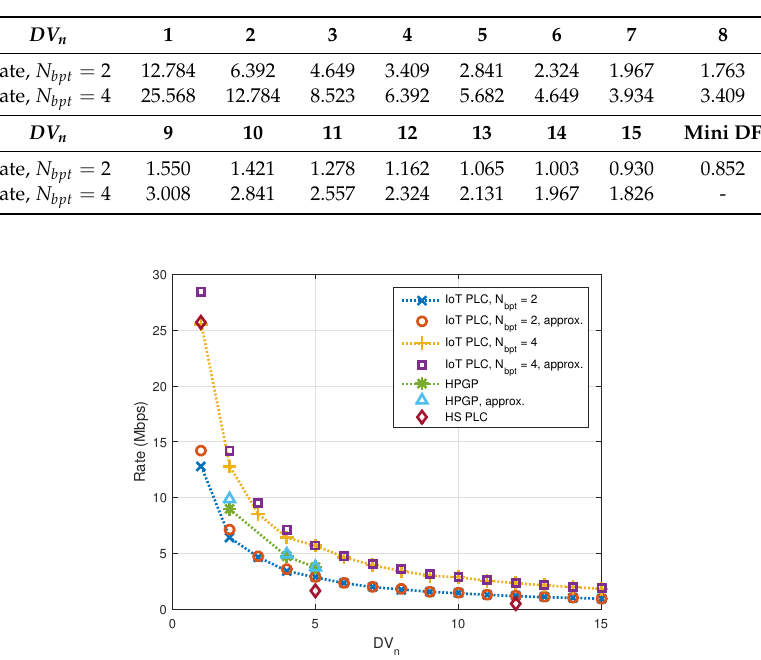
Table 3. Transmission rate for IoT PLC (Mbps).